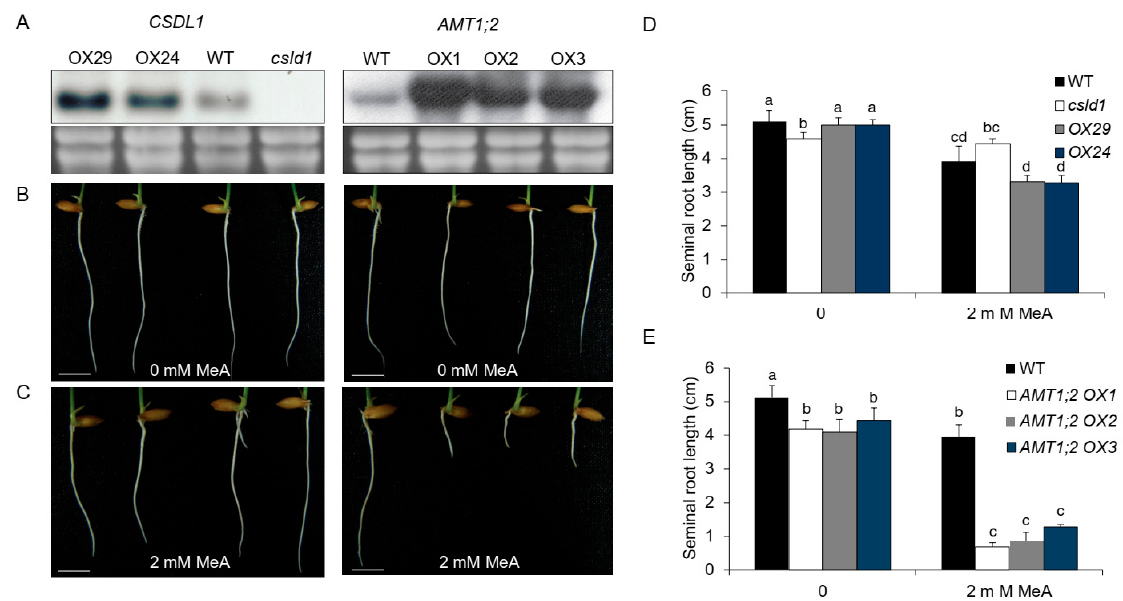
(WT) RNAi 5-2 ( Ri 5–2 ) and RNAi 3-1 ( Ri 3–1 ) ( C ) when cultured with 0.1 mM NH 4+ . AMT1 RNAi mutants cultured with 0.1 mM NO 3 − . ( D ) Root hair length ( E ) and root hair density of wild-type (WT) RNAi 5-2 ( Ri 5–2 ) and RNAi 3-1 ( Ri 3–1 ) (f) when cultured with 0.1 mM NO 3 − . Scale bars = 500 µ m. Bar graphs show mean values ± standard error of means ( n = 10). Different letters indicate significant differences between groups according to Tukey’s HSD test ( p < 0.05).